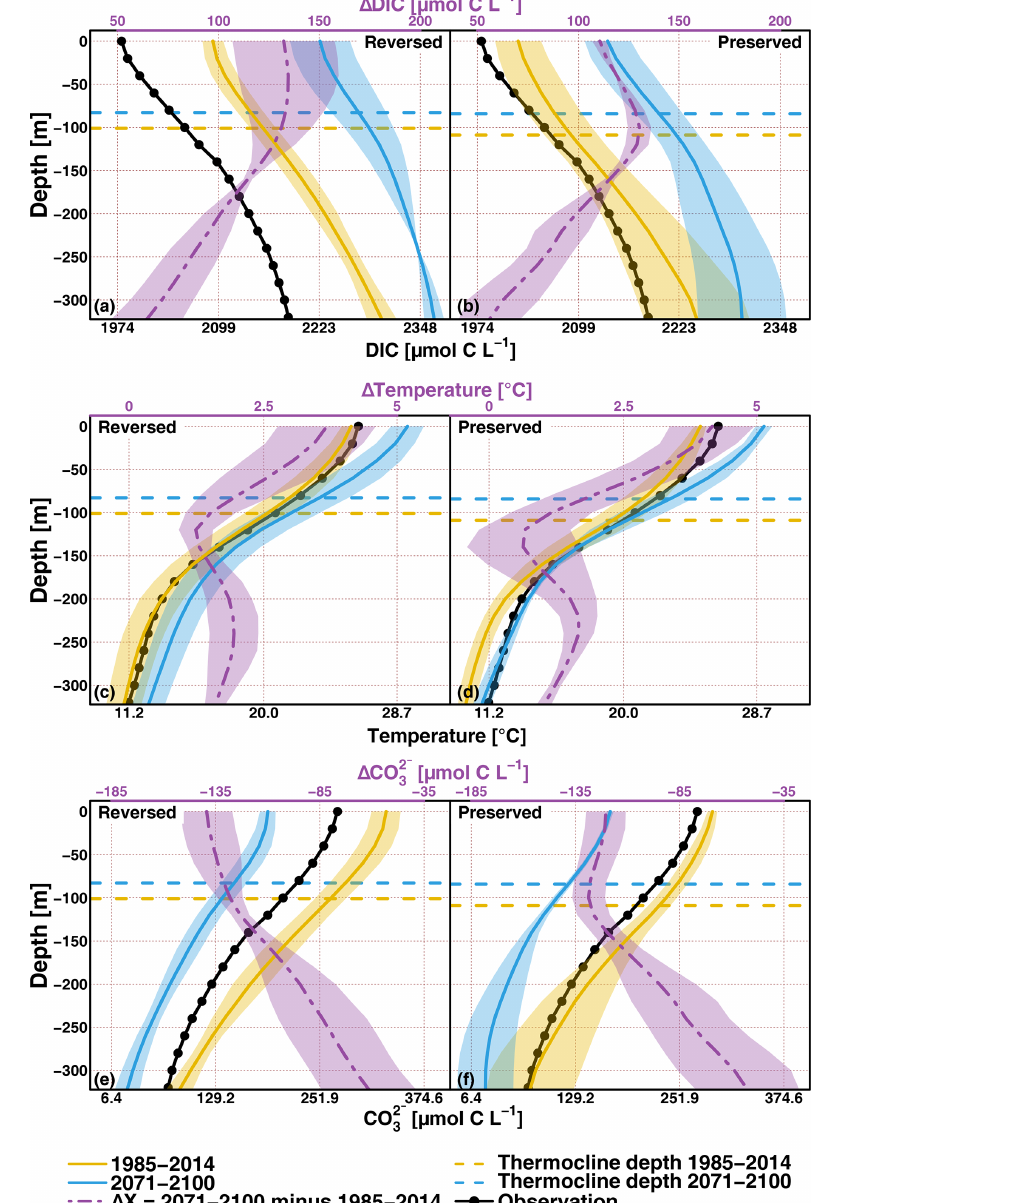
Figure 9. Multi-model mean of vertical DIC (in µmolCL − 1 , a and b ), temperature (in ◦ C, c and d ), and carbonate ion concentration (in µmolCL − 1 , e and f ) profiles over the 1985–2014 (in yellow lines) and 2071–2100 (in blue lines) periods for reversed (a, c, e) and preserved (b, d, f) models. The profile difference between both period profiles ( (cid:49) ) is given as purple dashed–dotted lines. The black lines with dots are the observed profile for the three variables. The dashed horizontal lines indicate the average thermocline depth for each groups and time periods. A value of 1 standard deviation is given in shaded